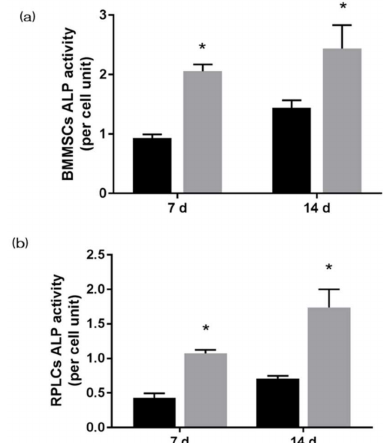
Figure 7. Alkaline phosphatase (ALP) expression was measured for bone di ff erentiation, which is the initial reaction of induction of hard tissue di ff erentiation. ALP expression in bone marrow cells seven and 14 days after the start of culture was significantly higher on the material surface of the test group. (Gray bar—untreated surface, black bar—UV-treated surface). (*: p < 0.05) ( a ) BMMSCs; ( b )